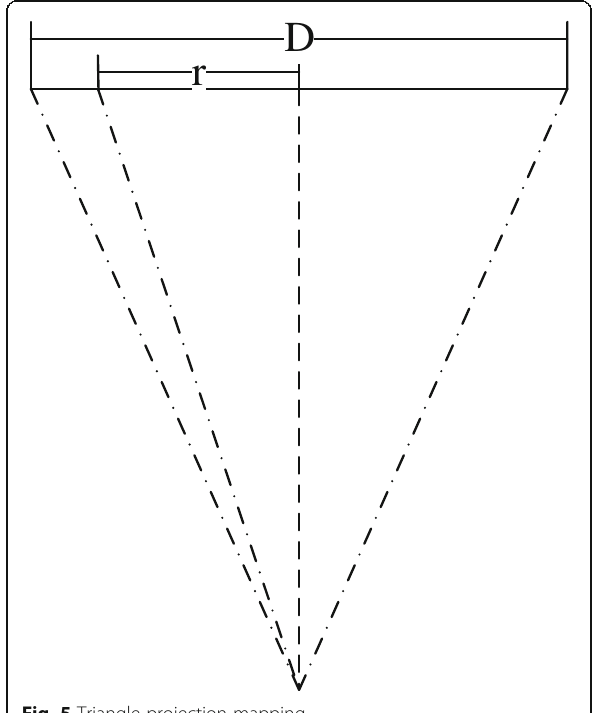
Fig. 5 Triangle projection mapping